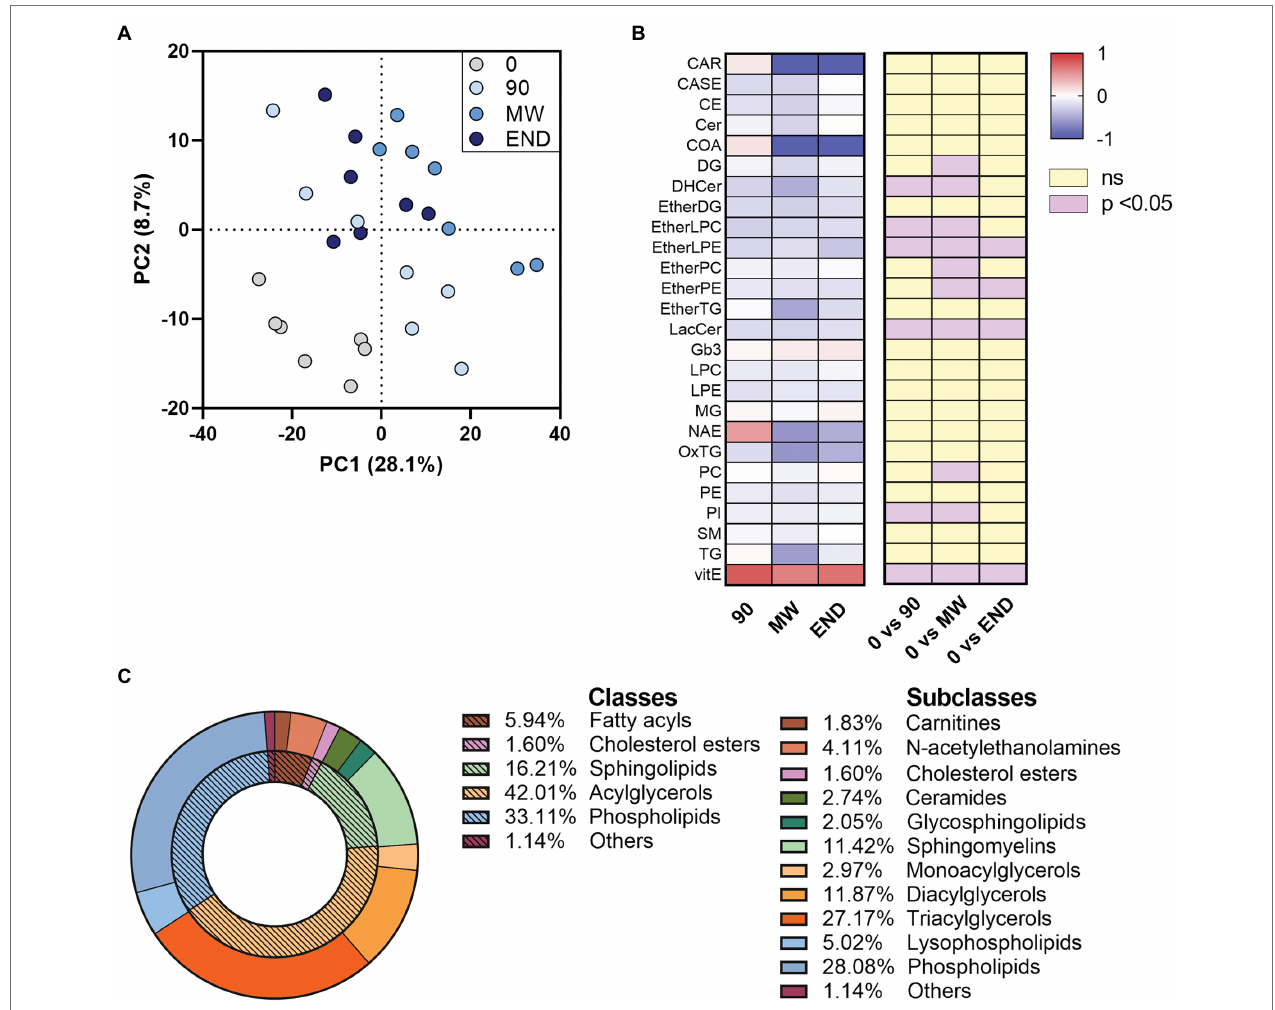
FIGURE 1 | Alterations in circulating lipidome during 10 months of chronic hypoxia in the Antarctica. (A) Multivariate analysis visualized as principal discriminant analysis of lipids in plasma after 0, 90, 150–180 (MW), and 300 days (END) in the Antarctica. (B) Discriminant lipids were chosen between those with a VIP > 1.0, then ordered and summed according to their class, and finally visualized as a heat map after transformation to values of z . Data are shown as log-fold change of each time points (90, MW, END) over baseline values. The three columns on the right show the significance of the difference vs. time 0 by one-way ANOVA and